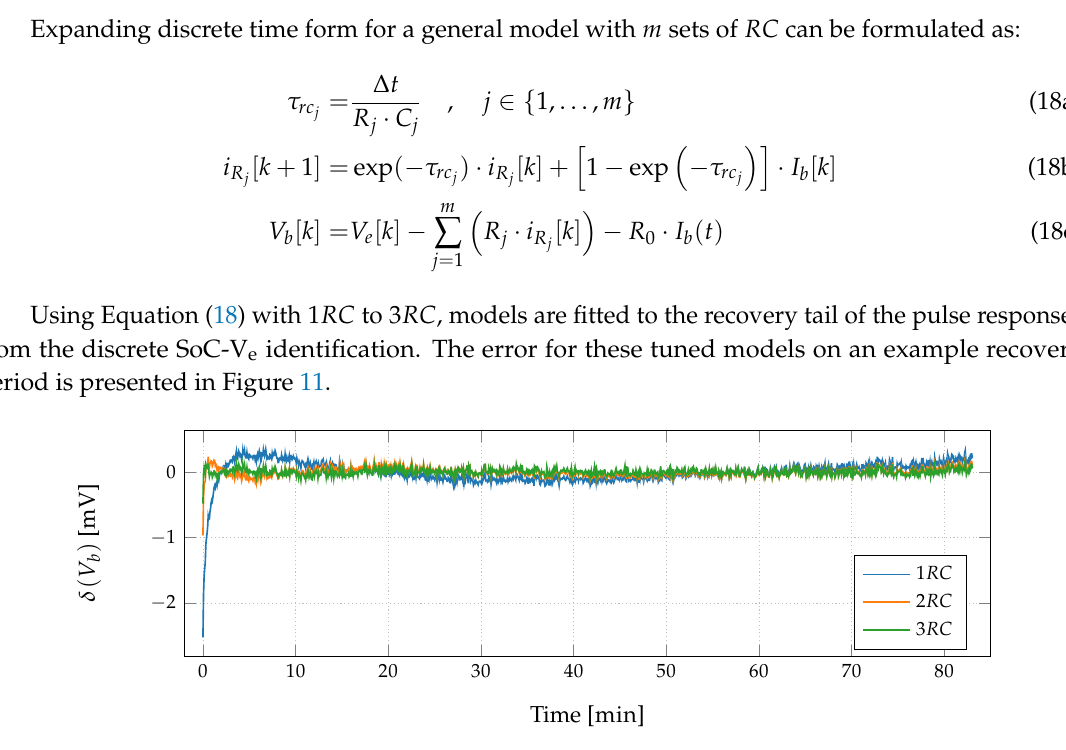
Figure 11. Error of the models with different number of RC sets, tuned to the recovery period of an identification pulse in the discrete